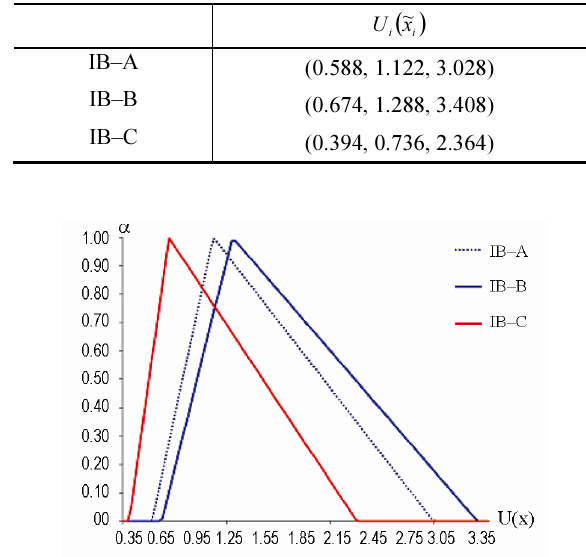
Table 5. Fuzzy utility values for building alternatives